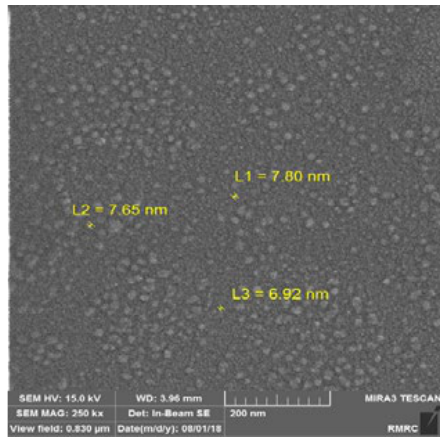
Fig. 6. FESEM image of MPA-capped CuInS Fig. 6: FESEM image of MPA-capped CuInS 2 QDs